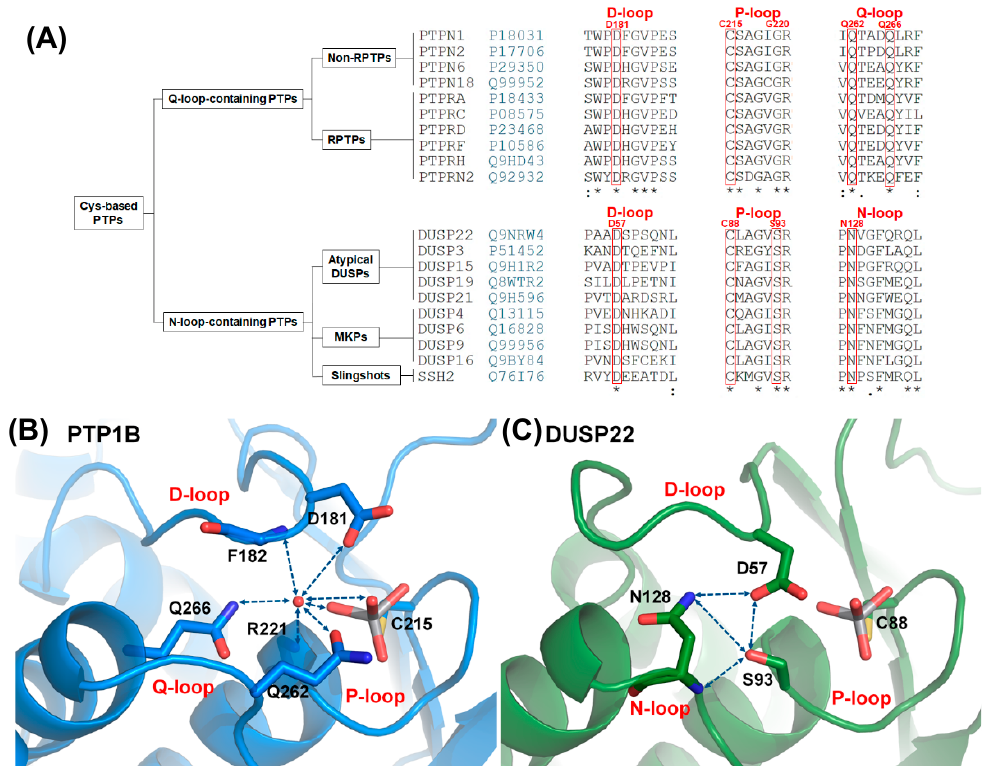
Figure 1. The D-, P-, N-triloop (DPN–triloop) interaction in N-loop-containing protein tyrosine phosphatases (PTPs). ( A ) The sequence alignment showed the difference between Q-loop-containing PTPs and N-loop-containing PTPs. N-loop-containing PTPs had an N-loop motif (PNXXF), which was different from the Q-loop motif (QXXXQ). The key residues (red) in PTP1B and DUSP22 are labeled above the sequence alignment. ( B ) In the structure of PTP1B (PDB ID: 3I80), structural water (red ball) can form the hydrogen bonding with the side chain of D181, the side chain of Q262, the side chain of Q266, the backbone amide of F182, the backbone amide of R221, and the oxygens of the ligand in active site. This water-mediated DPQ-triloop interaction connected the D-loop, the P-loop, the Q-loop, and the ligand, and aligned these residues to the correct position. ( C ) In the structure of DUSP22 (PDB ID: 6LVQ), the active site contained a hydrogen bonding network named the DPN–triloop interaction, which was formed by three residues: D57 in the D-loop, S93 in the P-loop, and N128 in the N-loop. The side chains of D57, S93, and N128 formed hydrogen bonds with each other, and the backbone amide of N128 formed hydrogen bonding with the side chain of S93. Hydrogen bonding is displayed as blue dotted lines, and the residues as well as the ligand, VO 4 , are shown by